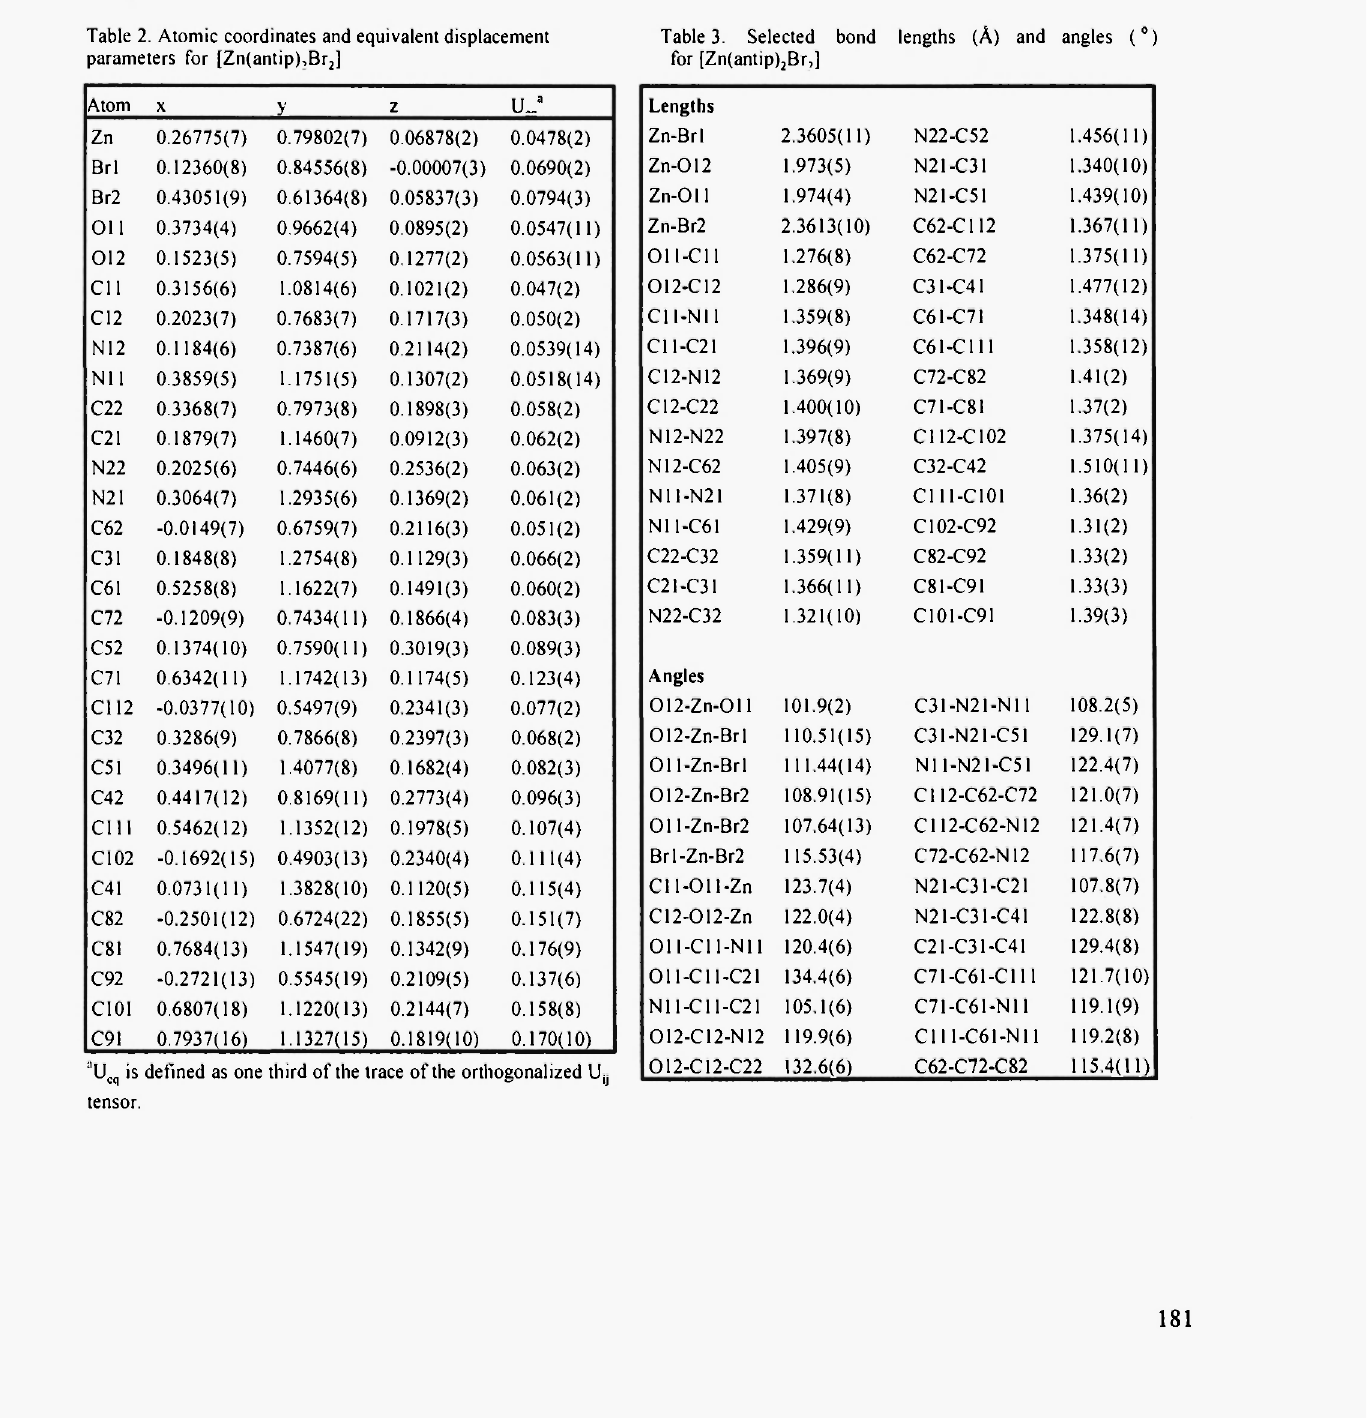
Table 2. Atomic coordinates and equivalent displacement Table 3.